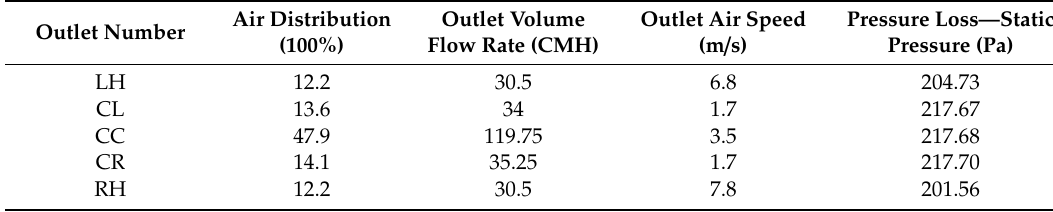
Table 2. Defrosting duct calculation